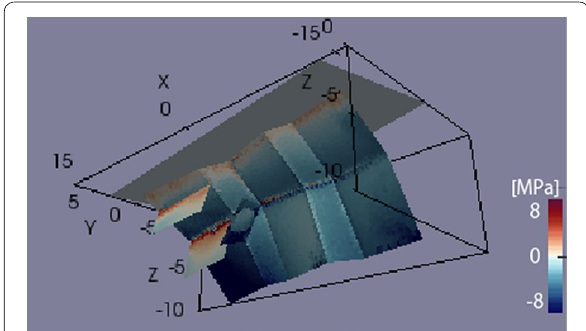
Fig. 12 Spatial distribution of Coulomb stress change for Model C at the static equilibrium after the dynamic rupture event